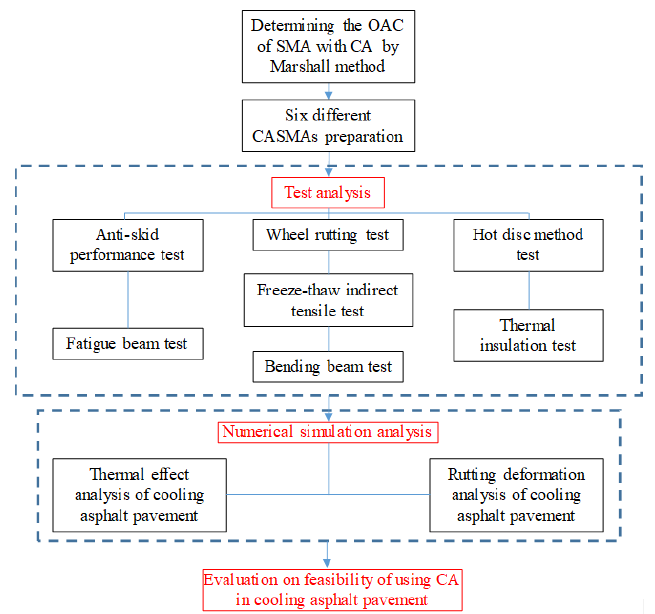
Figure 1. Flow chart of the research approach.